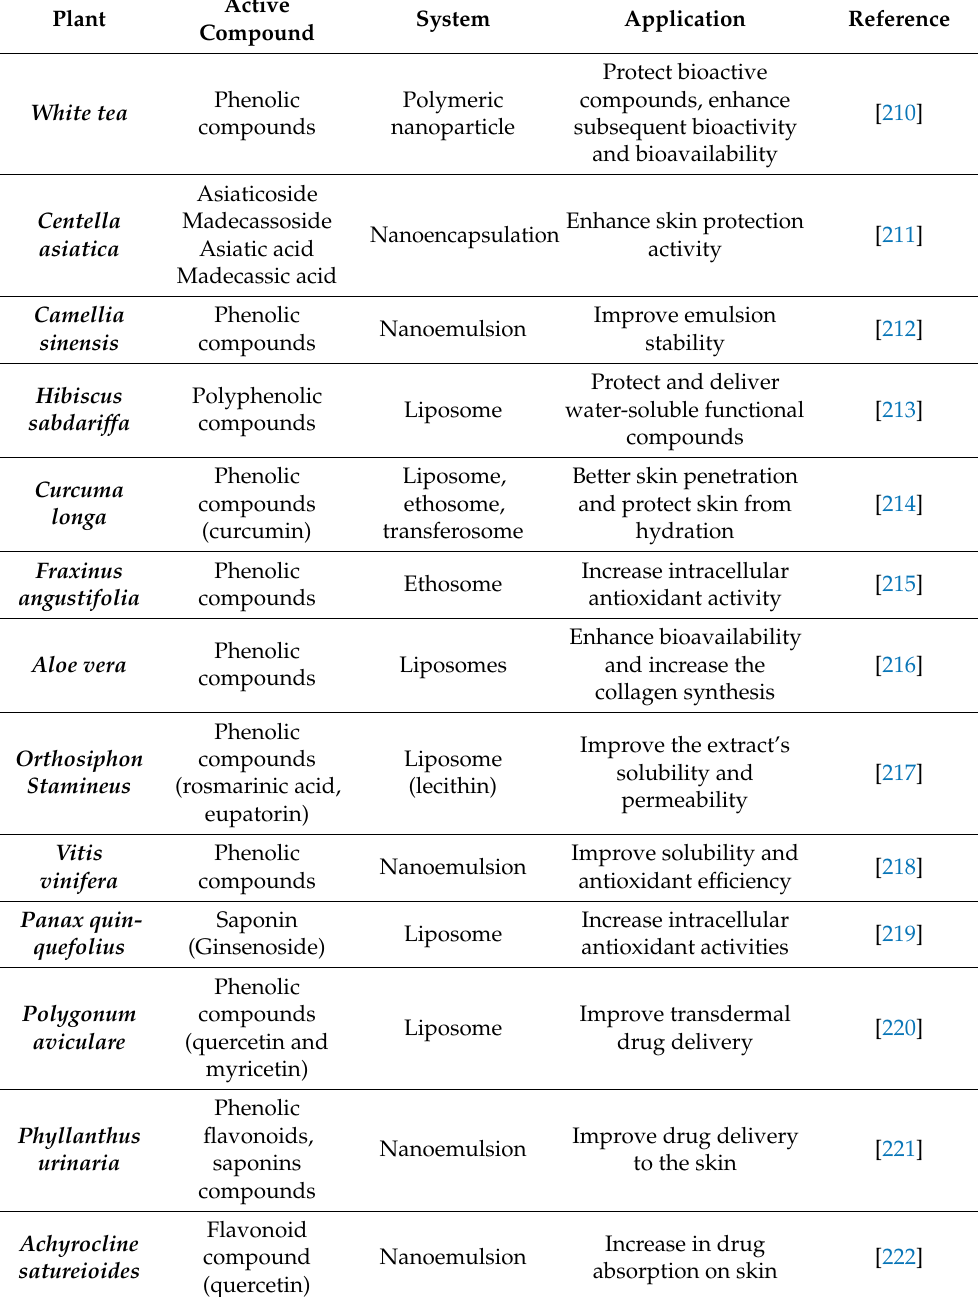
Table 3. List of nanoformulations in